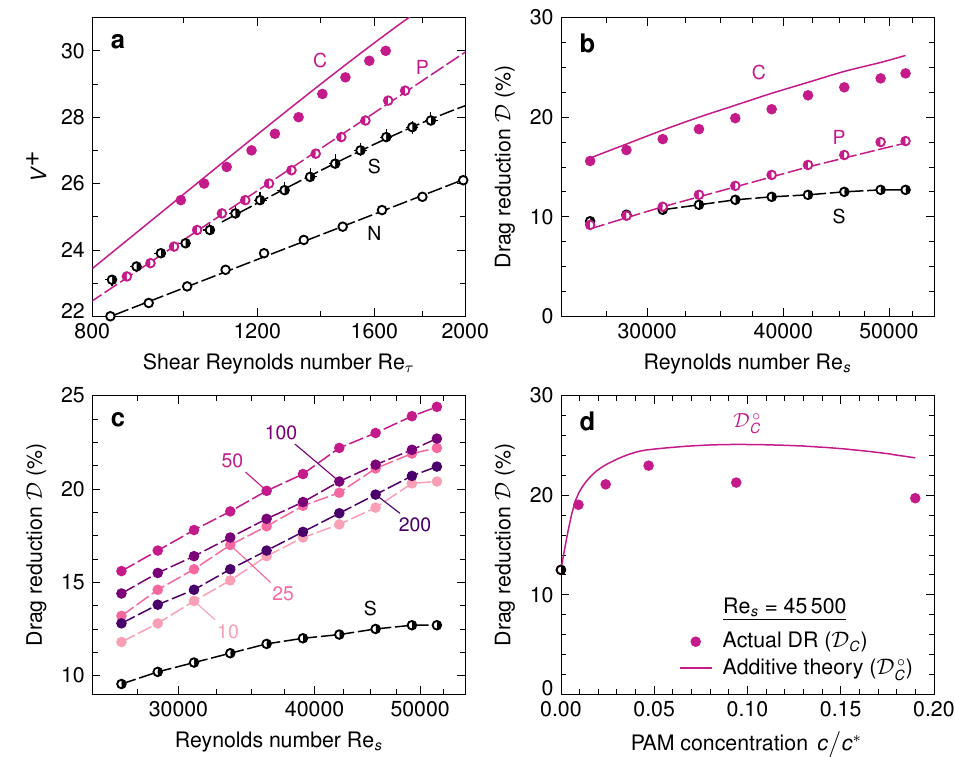
Figure 2. ( a ) Experimental friction curves and ( b ) the percentage drag reduction for the no-slip rotor in water ( N ) and in 50ppm aqueous PAM ( P ), as well as for the superhydrophobic grooved rotor in water ( S ) and in 50ppm aqueous PAM ( C ). The solid curves denote the ideal estimates predicted by our additive model. ( c ) Combined percentage drag reduction for the superhydrophobic rotor in PAM solutions of various concentrations (labeled in ppm). ( d ) The actual percentage drag reduction , and the ideal estimate , as a function of c / c ∗ at Re s = D C D ◦ C